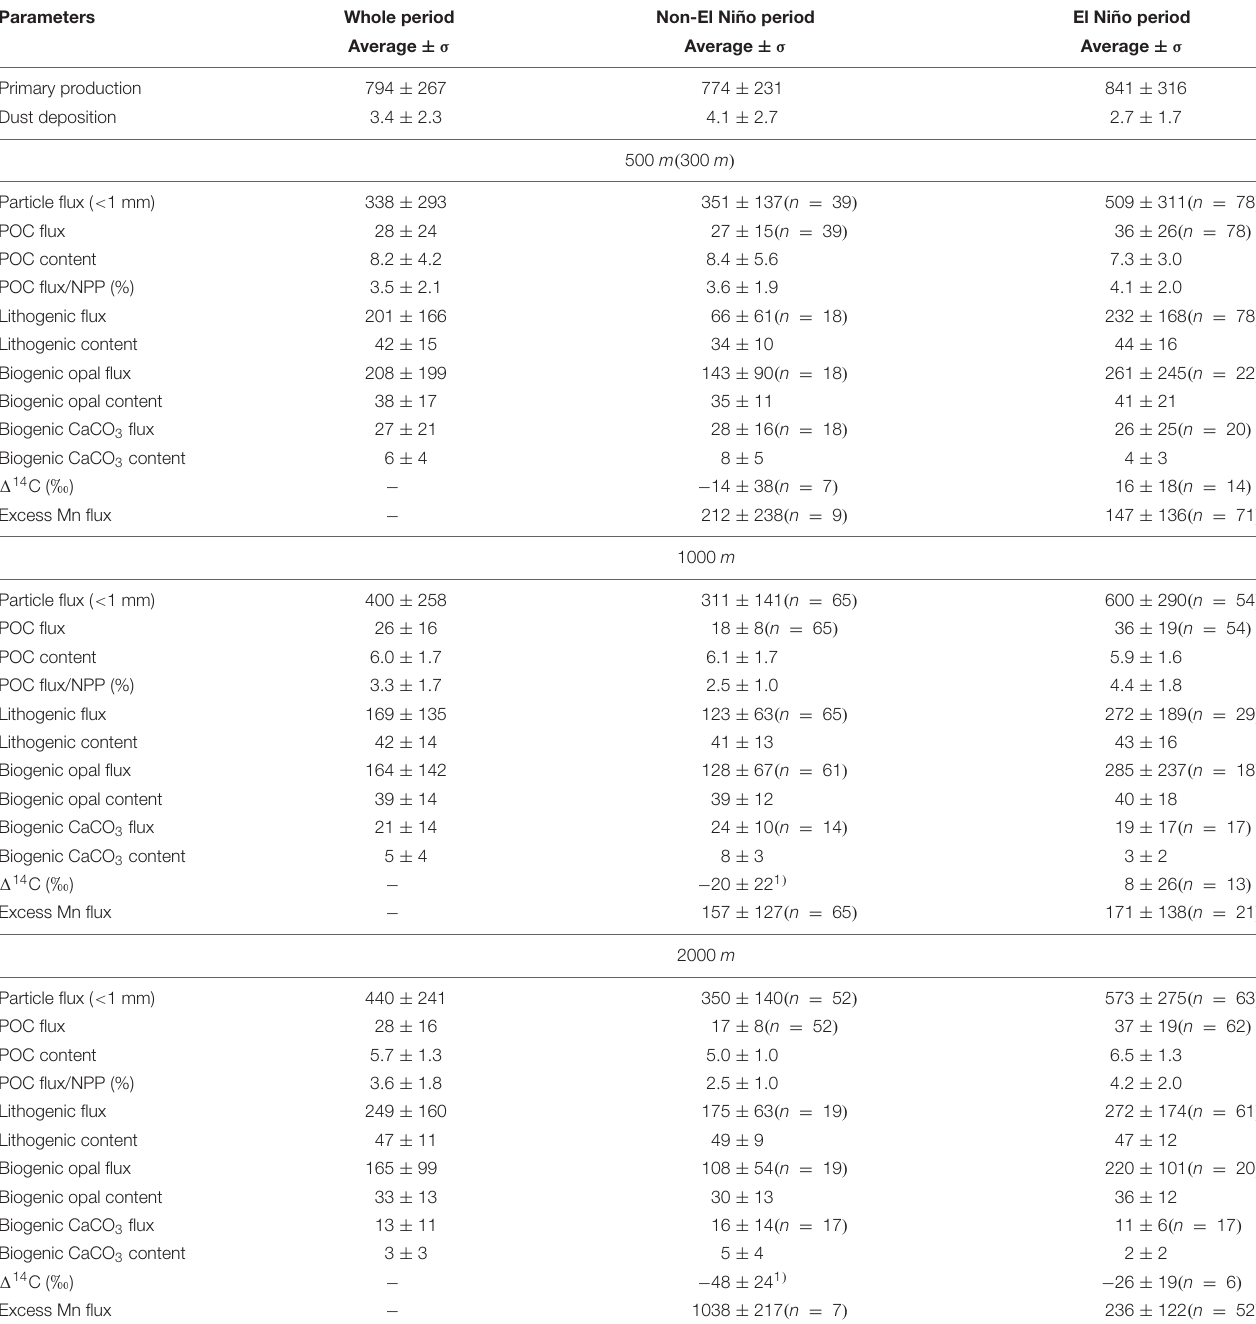
TABLE 1 | Values of observed parameters averaged over the entire study period (July 2011-September 2017), the non-El Niño period (July 2011-March 2014), and the El Niño period (June 2014-September 2016).